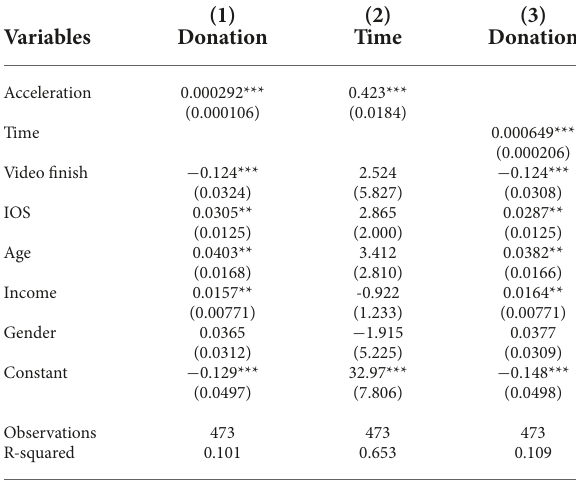
TABLEA2 Themediationmodelisre-estimatedusingcontrolvariables and is shown to confirm the previous result. (1) (2) (3)